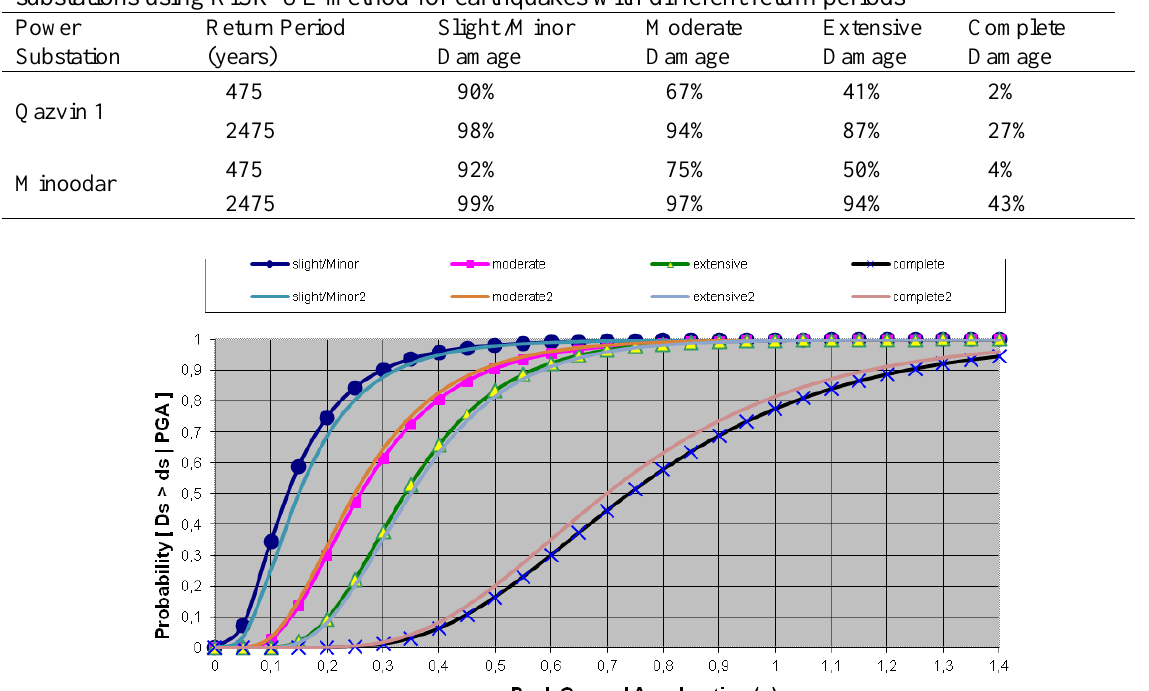
Figure13. Comparison of fragility curves of HAZUS and RISK-UE methods for low voltage power substations with unanchored components (the curves with label 1 are corresponded to HAZUS and the curves with label 2 are related to